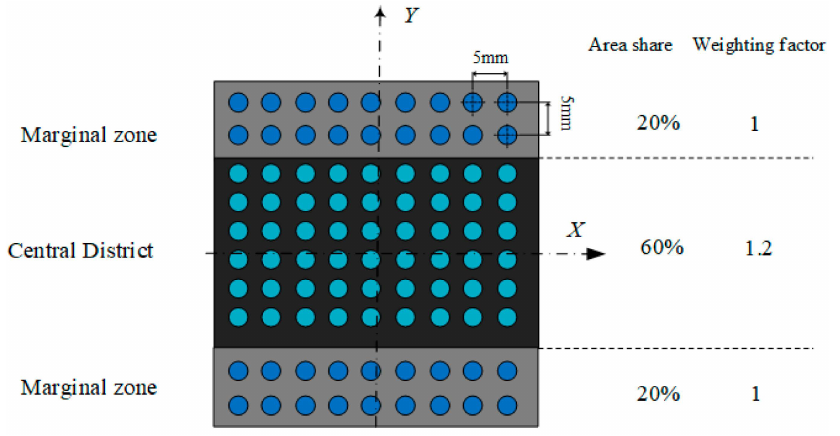
Figure 3. Tire contact stress distribution diagram.